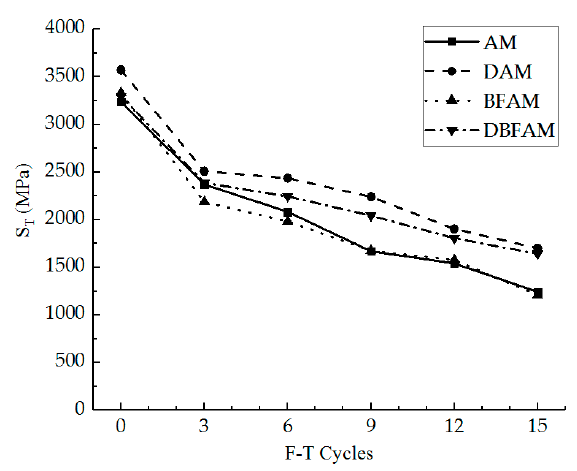
Figure 9. Failure stiffness modulus under F–T cycles.